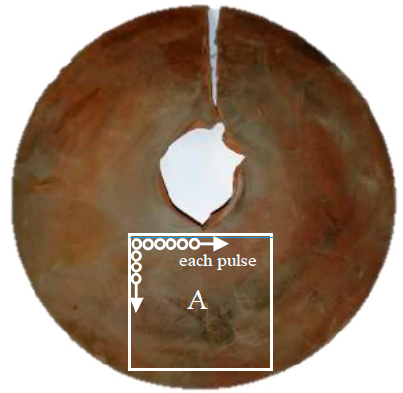
Figure 2. Surface conditions of the tested composite insulators.